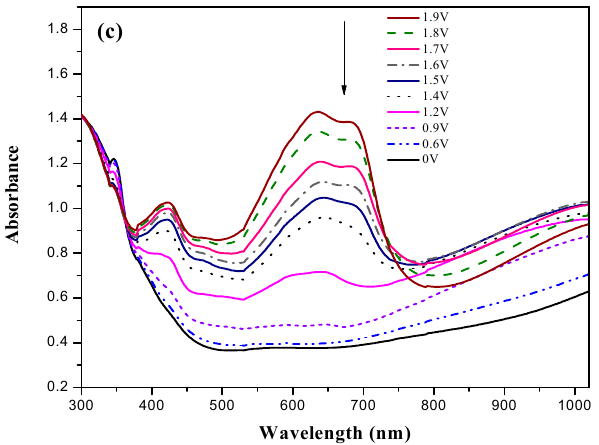
Figure 8. UV-Visible spectra of: ( a ) PBCz/double-layer PEDOT-PSS ECD; ( b ) P(BCz- co -ProDOT)/double-layer PEDOT-PSS ECD; and ( c ) P(BCz- c o-ProDOT)/triple-layer PEDOT-PSS ECD.